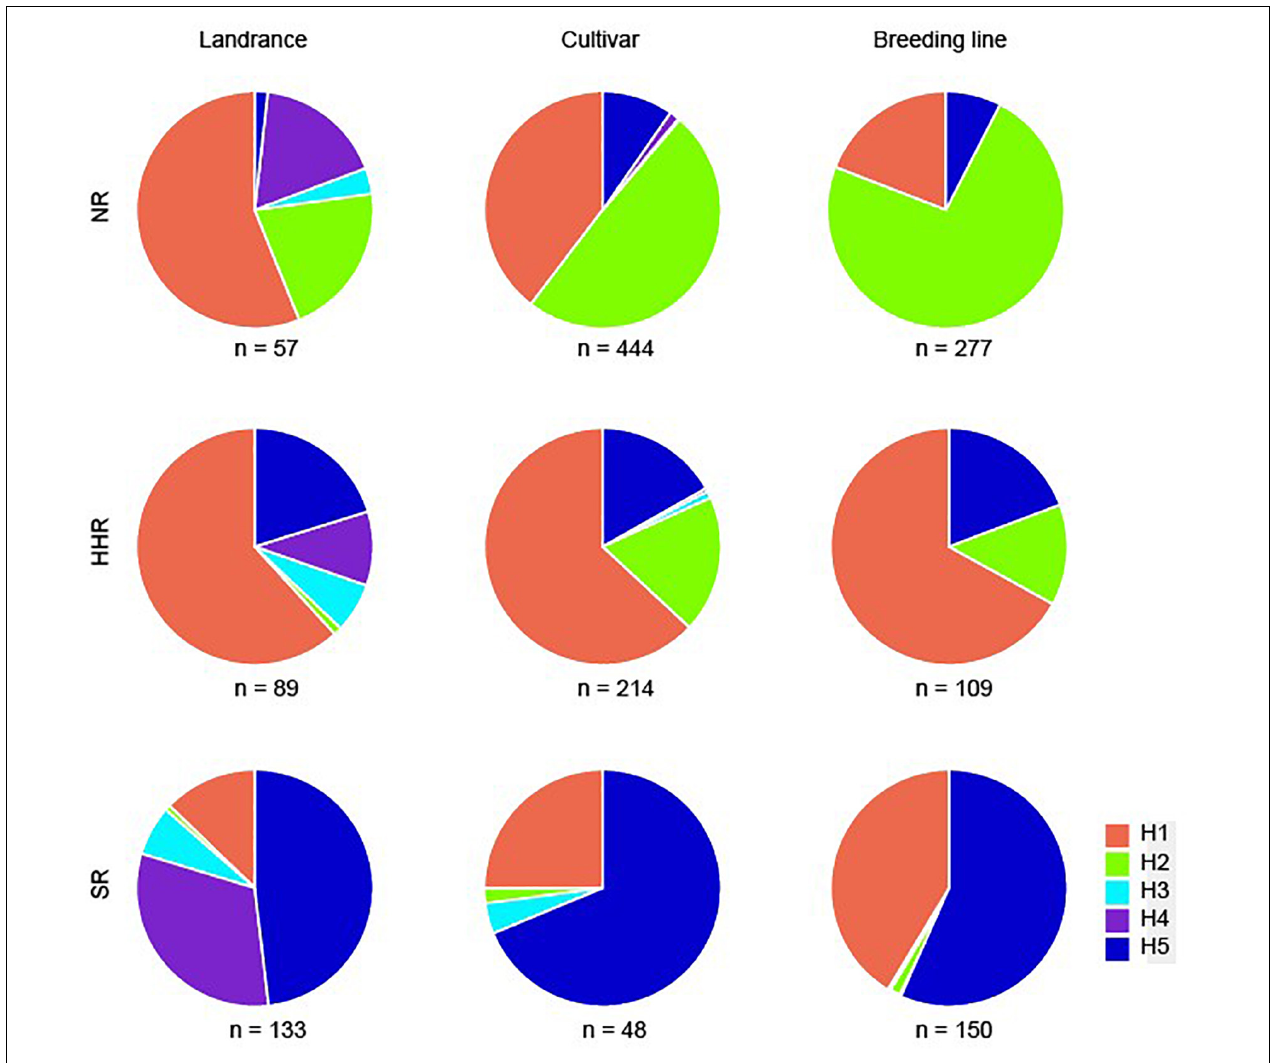
FIGURE 4 | Distribution of GmSALT3 haplotypes in Chinese soybean landraces, cultivars, and breeding lines from the three ecoregions. NR, northern region of China; HHR, Huanghuai region of China; SR, southern region of China.